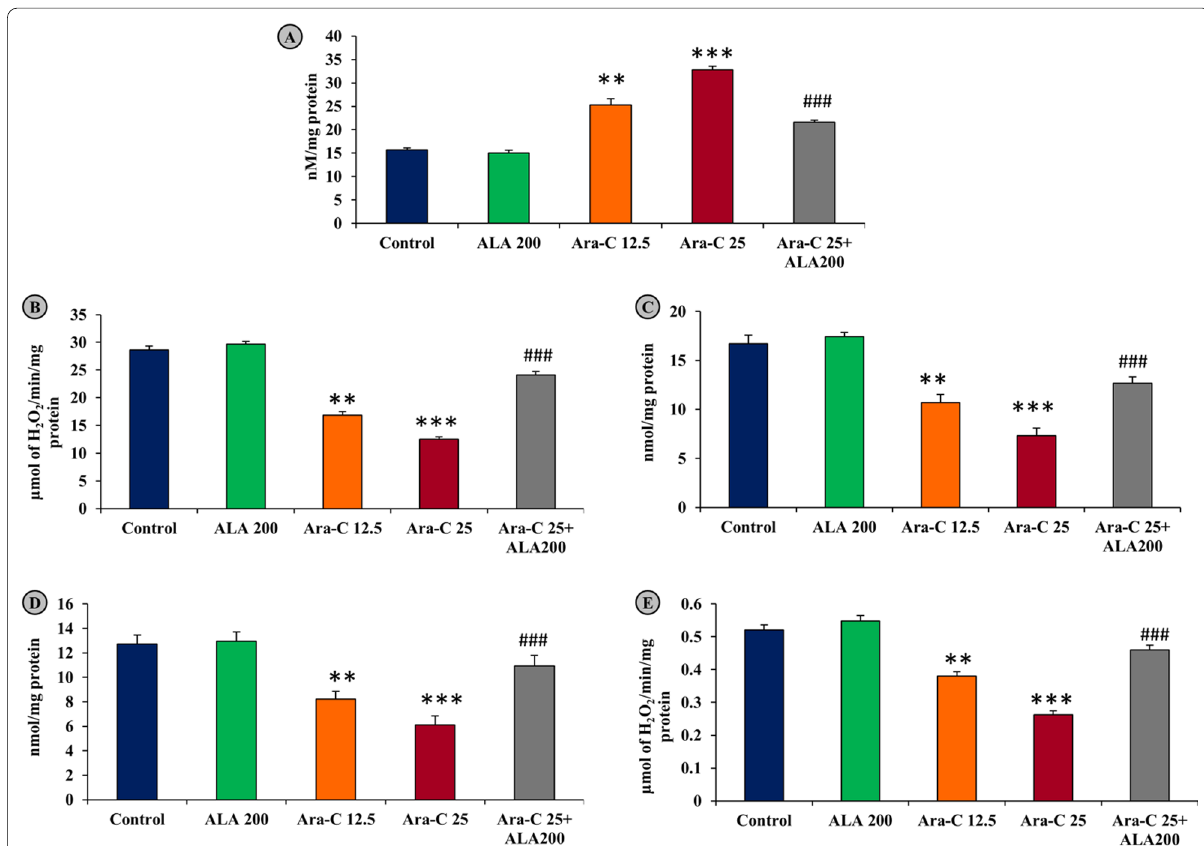
Fig. 4 Effect of Ara-C and ALA on fetal oxidative stress markers A MDA, B SOD, C GSH, D GSH-Px, and E Catalase. All the values are expressed as mean SEM, ( n 10). *** P < 0.001 versus control, ** P < 0.01 versus control; ### P < 0.001 versus Ara-C 25 mg/kg. ALA, Alpha-lipoic acid, Ara-C ± = cytarabine, GD gestation day, GSH glutathione, GSH-Px glutathione peroxidase, g grams, MDA malondialdehyde, SOD superoxide